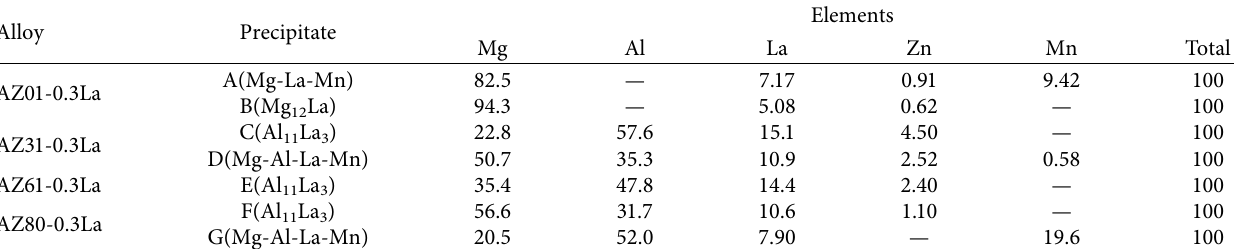
Table 2: EDS analysis results of precipitates in as-cast studied alloys (in %). Alloy